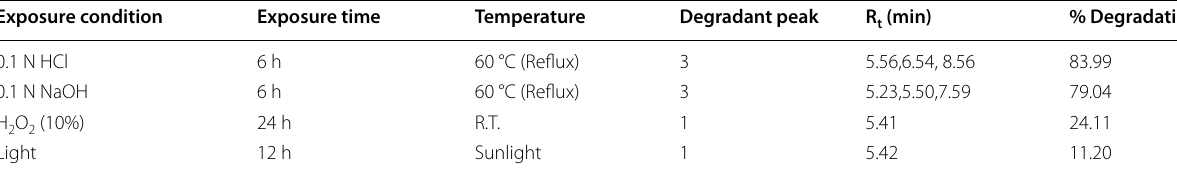
Table 7 Forced degradation study